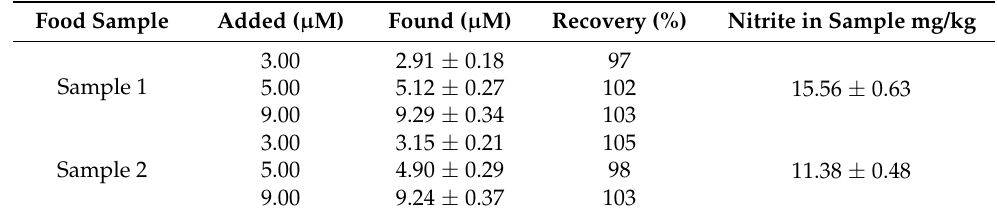
Table 4. Determination of nitrite in Sample 1 (smoked sausages) and Sample 2 (sausages) using the Au/FePc(tBu) 4 /GCE ( n =